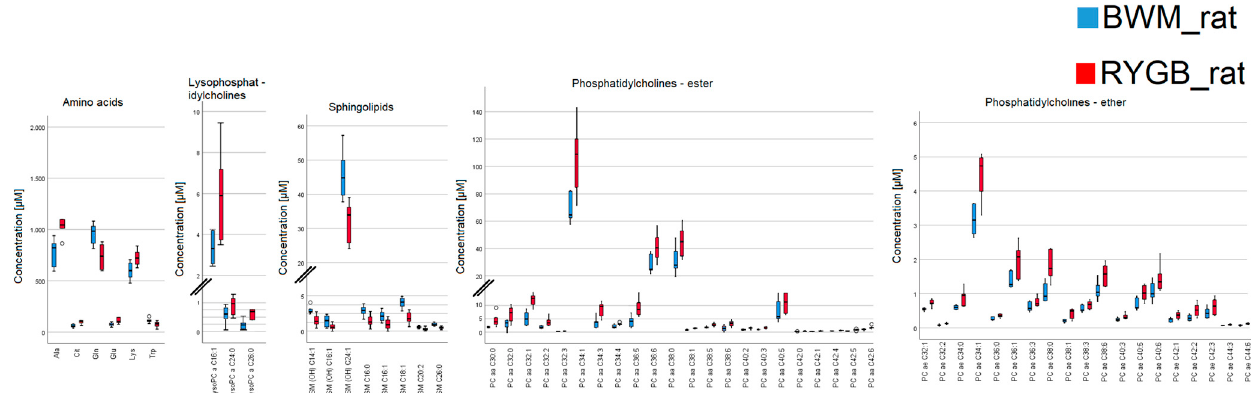
Figure 6. Metabolomic profile of 62 significantly different parameters of amino acids; lysophospha- tidylcholines; sphingolipids; acylcarnitines; phosphatidylcholines with ester bonding; phosphati- dylcholines with ether bonding, between rats with RYGB and rats with diet restriction (BWM) four weeks after start of the interventions.